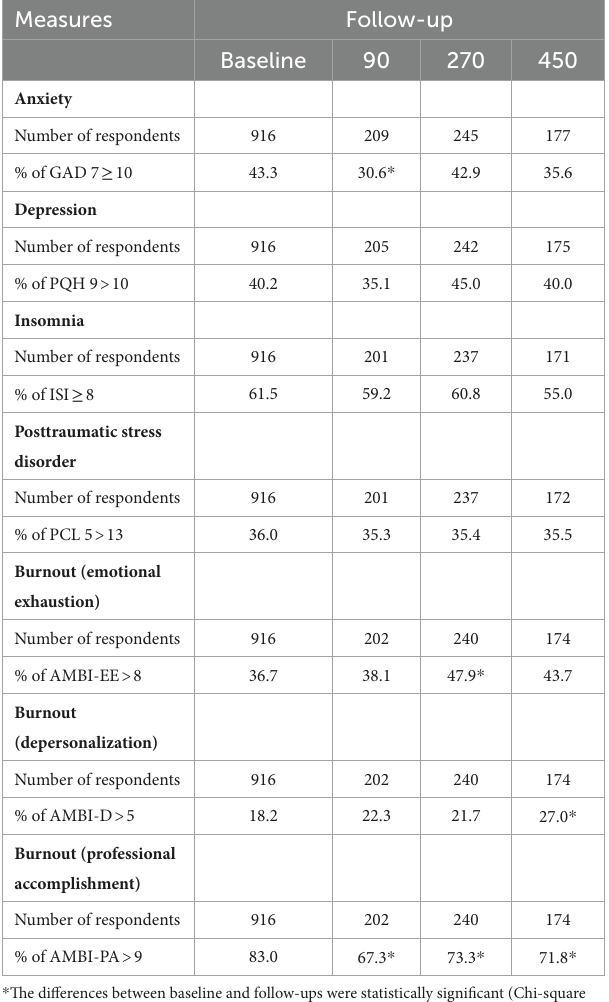
TABLE 2 Percentage of subjects whose scores were above the cut-off for each instrument in the different